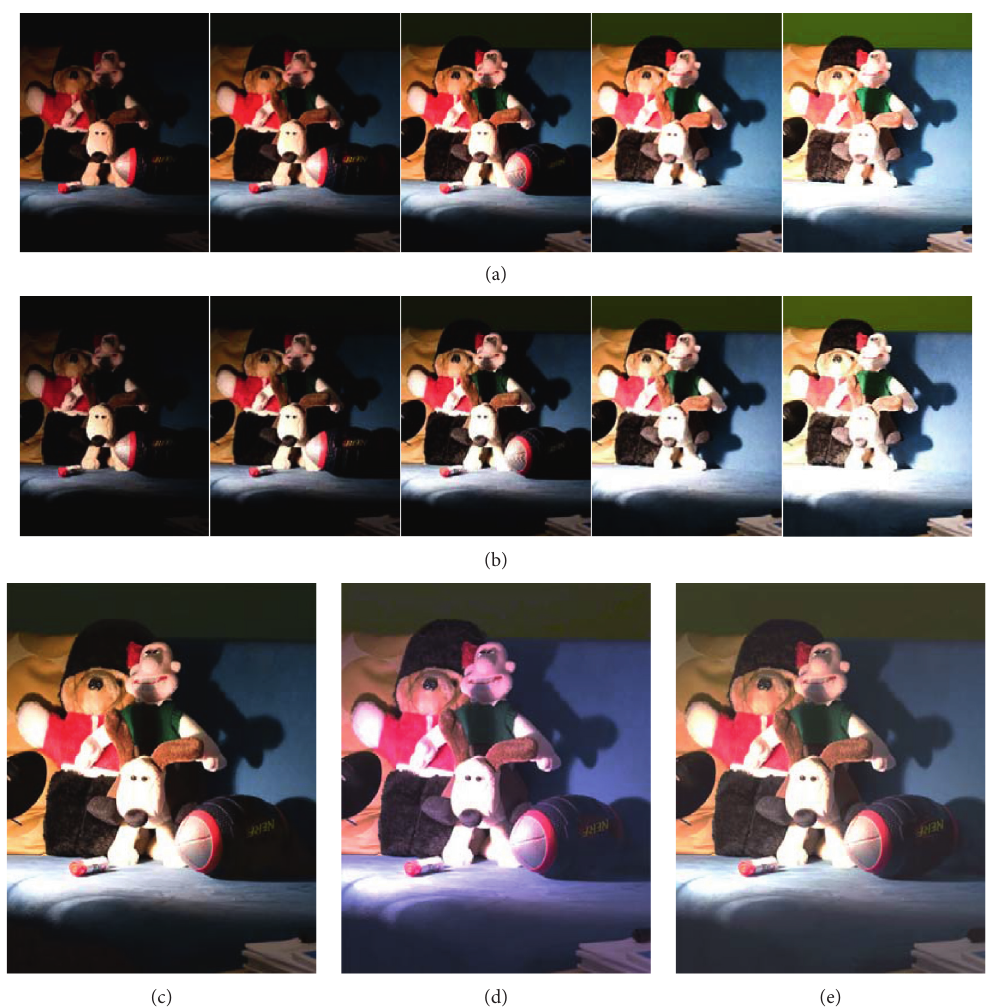
Figure 8: Multiple-exposure image sequences Puppet fusing result. (a) Multiple-exposure image sequences Puppet. (b) Puppet after compressive sensed and reconstructed (c) Reference [31]. (c) SEN [25]. (d) HU [30]. (e)